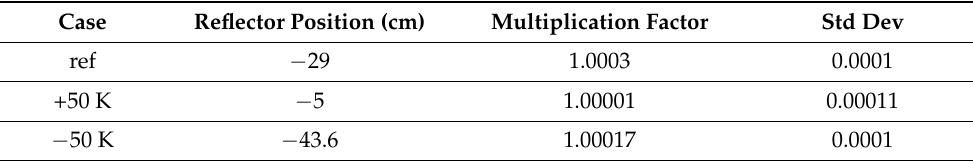
Figure 16. Study of the reflector position required to compensate for the system temperature change. Table 2. Exact criticality data and reflector position for the reference system and a postulated temperature change of ± 50